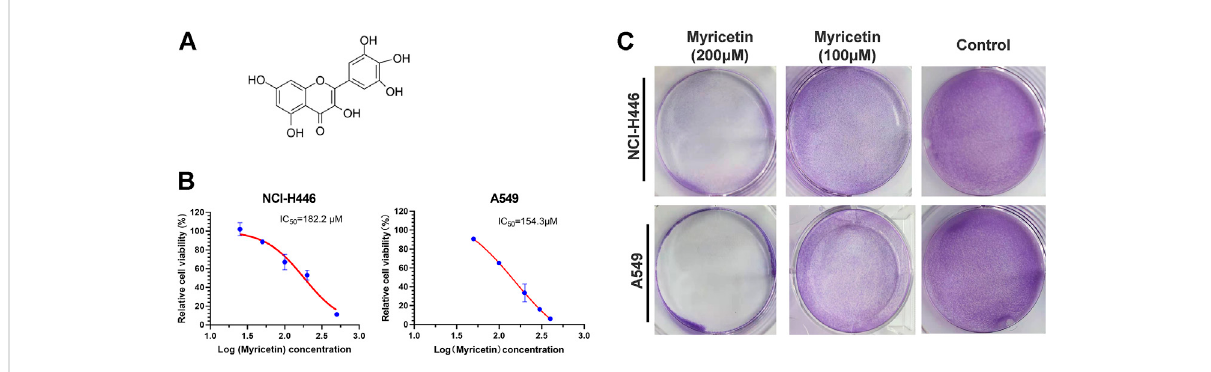
FIGURE 1 Inhibitory effect of myricetin on lung cancer cells. (A) Chemical Structure of Myricetin. (B) Half maximal inhibitory concentration (IC50) of Myricetin inhibiting the proliferation of NCI-H446 and A549 cells. (C) Crystal violet staining of NCI-H446 and A549 cells treated with Myricetin. The results were presented as mean ± standard